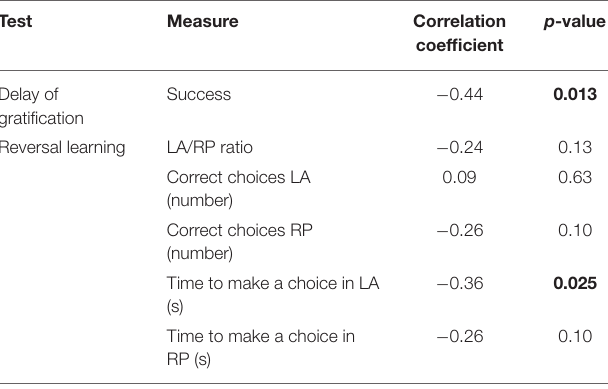
TABLE 3 | Correlation between aggression level and z -transformed inhibitory control